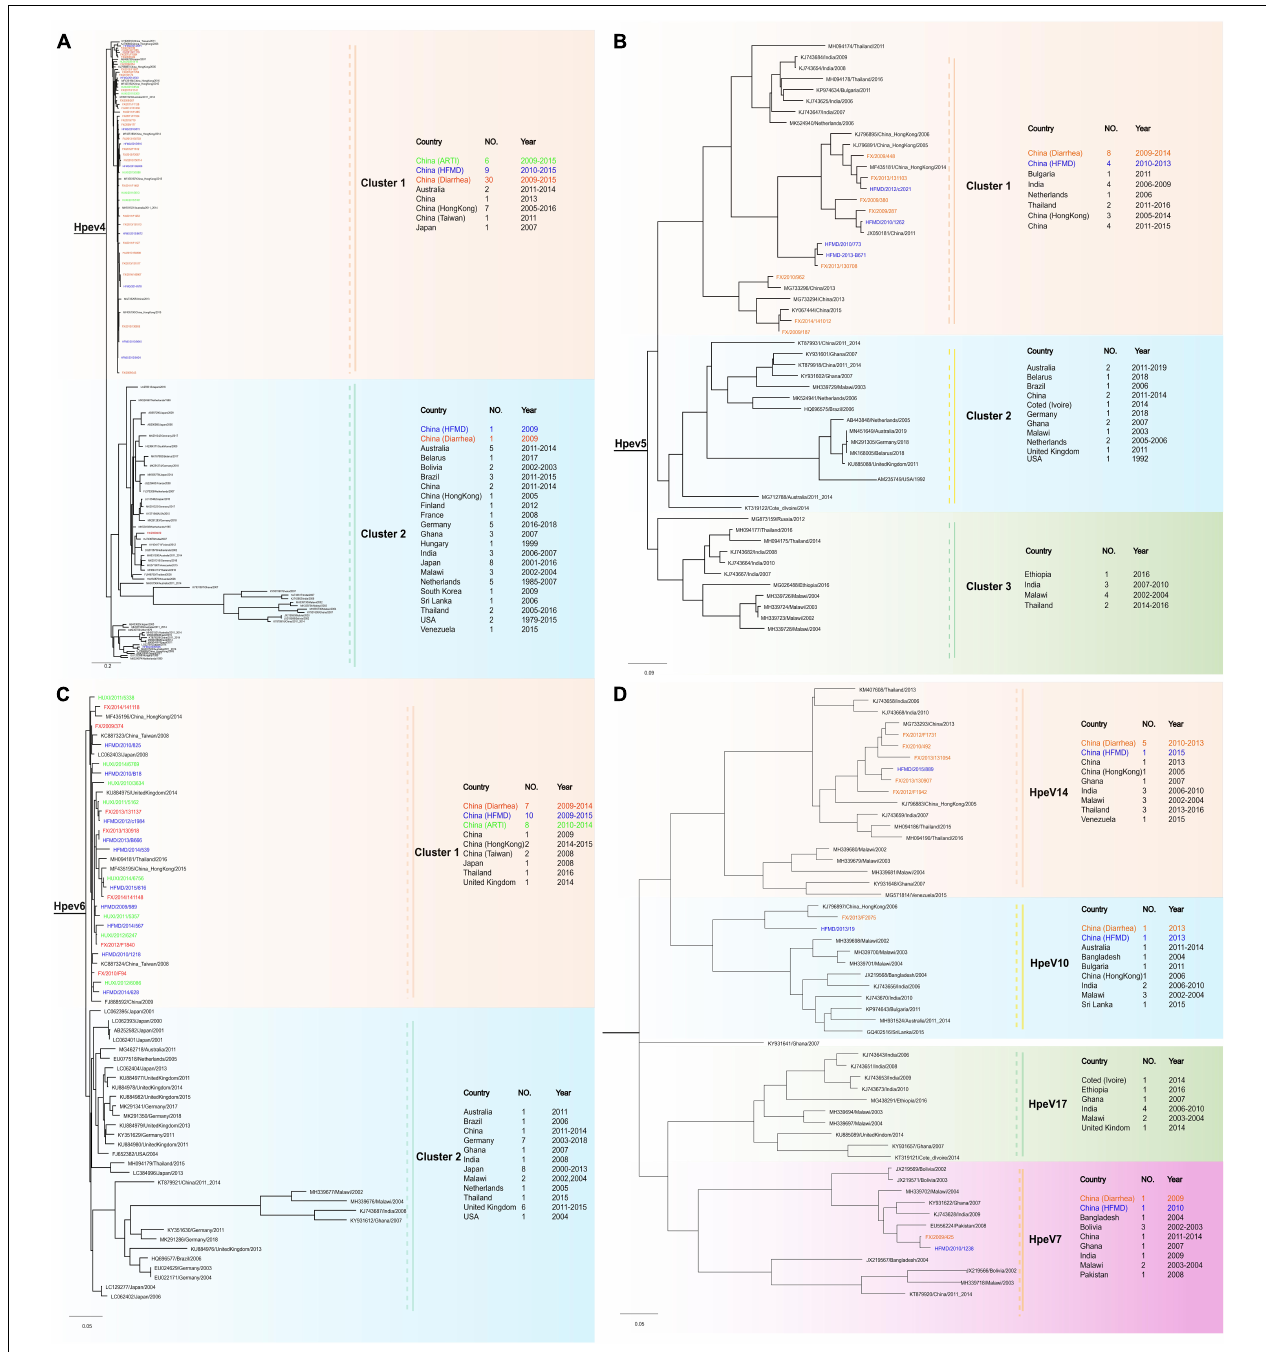
FIGURE 4 | Phylogenetic analysis of all the HPeV4–7, HPeV10, and HPeV14 strains based on the compete VP1 sequence. (A) Phylogenetic analysis of representative HPeV4 strains based on the compete VP1 sequence. (B) Phylogenetic analysis of representative the HPeV5 strains based on the compete VP1 sequence. (C) Phylogenetic analysis of representative HPeV6 strains based on the compete VP1 sequence. (D) Phylogenetic analysis of representative HPeV7, HPeV10, and HPeV14 strains based on the compete VP1 sequence. The phylogenetic trees were constructed with maximum likelihood method with 1,000 replicates using MEGA 7.0. The strains of black names were downloaded from GenBank and others were from our study. The strains of green names with the beginning of “HUXI” were isolated from Group 1 (patients with acute respiratory tract infection). The strains of red names with the beginning of “FX” were isolated from Group 2 (patients with diarrhea). The strains of blue names with the beginning of “HFMD” were isolated from Group 3 (patients with hand-foot-mouth disease).